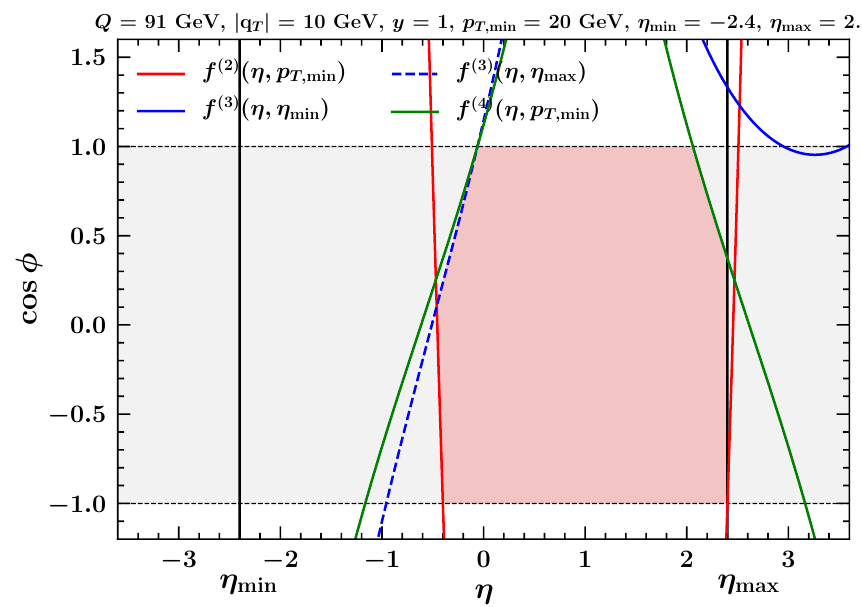
Figure 9 . The red area indicates the integration domain of the numerator of the phase-space reduc- tion factor eq. (C.13) for p T; min = 20 GeV and (cid:0) (cid:17) min = (cid:17) max = 2 : 4 at Q = 91 GeV, j q T j = 10 GeV, and y =